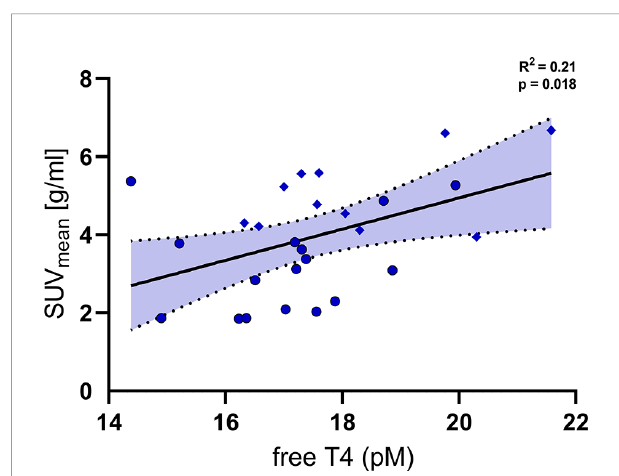
FIGURE 4 | Levels of free T4 were signi fi cantly associated with the uptake of fl uoro-deoxyglucose (SUV mean ) into supraclavicular brown adipose tissue (R 2 = 0.21, p=0.018). Diamonds: individual data points from trial 1 NCT03189511 (PET/MRI, BAT stimulation by Mirabegron and cold exposure), Circles: individual data points from trial 2 NCT03269747 (PET/CT, BAT stimulation by cold